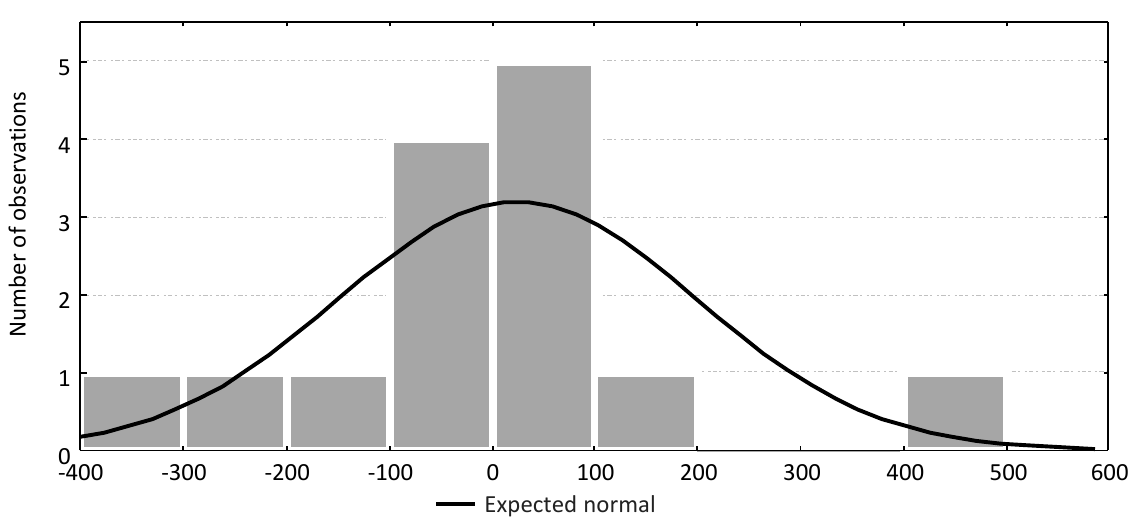
Figure 2. Distribution of excesses for the regression of contributions of members of the Deposit Guarantee Fund ( ) c from its volume ( ) x